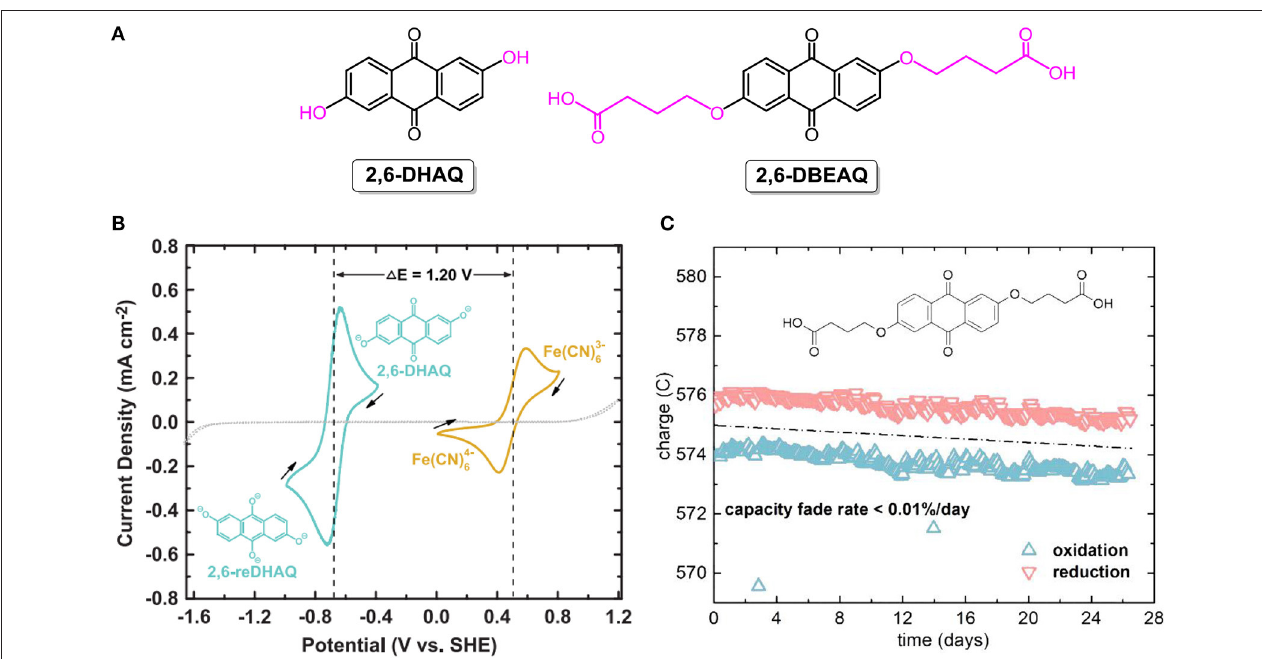
FIGURE 7 | (A) Molecular structures of 2,6-DHAQ and 2,6-DBEAQ . (B) Cyclic voltammogram of 2mM 2,6-DHAQ (dark cyan curve) and ferrocyanide (gold curve) scanned at 100 mV/s on glassy carbon electrode; arrows indicate scan direction. Dotted line represents CV of 1M KOH background scanned at 100 mV/s on graphite foil electrode. Reproduced with permission from ref. 76. Copyright 2015, American Association for the Advancement of Science. (C) Unbalanced compositionally symmetric cell cycling of 2,6-DBEAQ. Reproduced with permission from Kwabi et al. (2018). Copyright 2018,